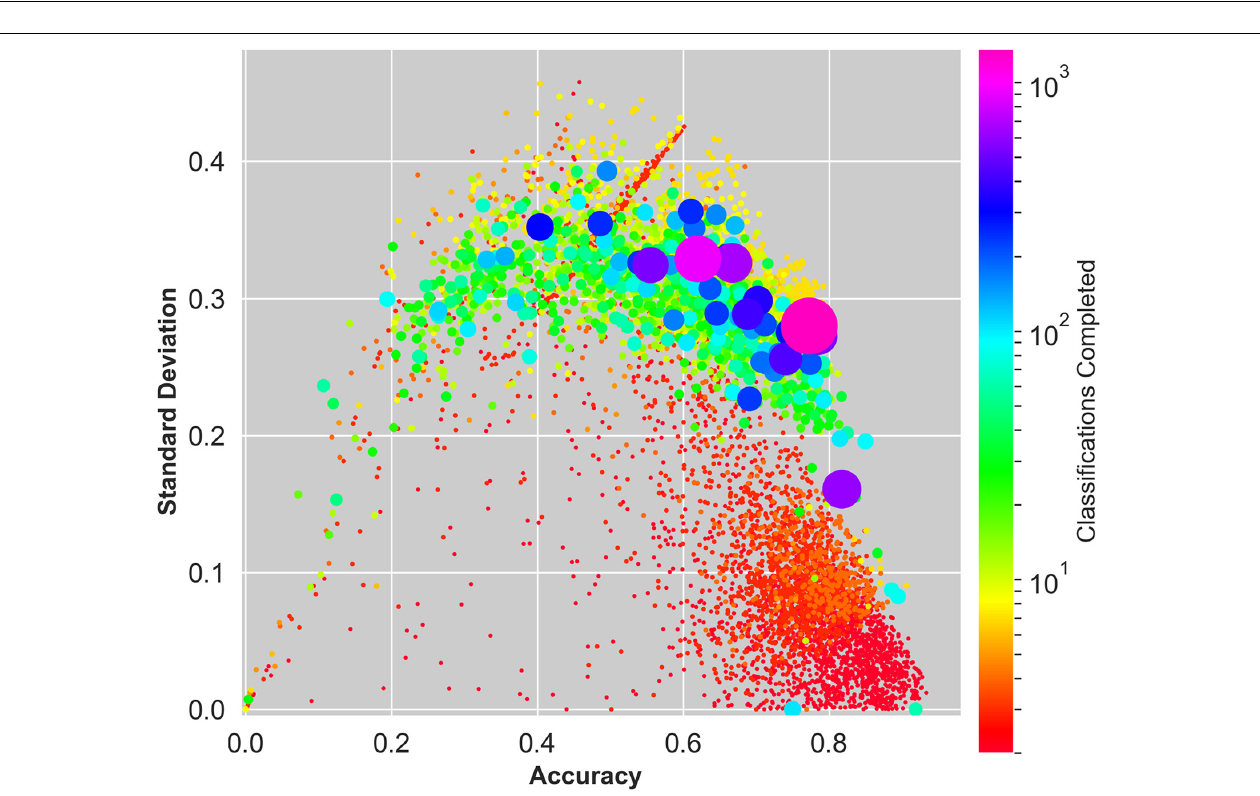
FIGURE 13 | Mapping of average accuracy, standard deviation of accuracies, and classifications completed. Each datapoint represents an individual player, and the size and color of the datapoint corresponds to the number of classifications completed. There is a key group of trustworthy players who have high average accuracy, low standard deviation of accuracies and have submitted many